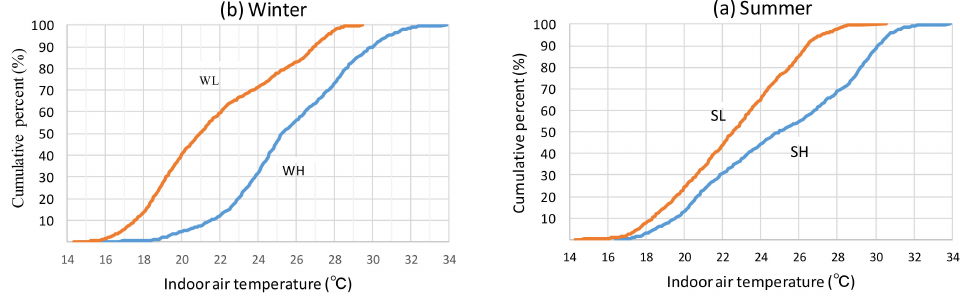
Figure 8. Indoor air temperature of higher and lower groups: ( a ) Summer and ( b )